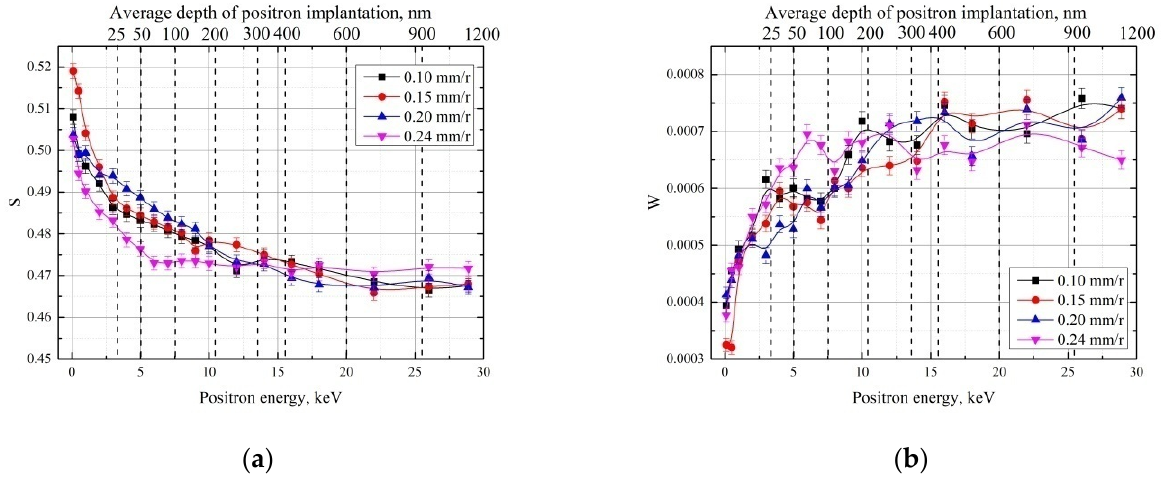
Figure 6. DBS-VEP depth profile of the S ( a ) and W ( b ) parameters for the white layer in GCr15